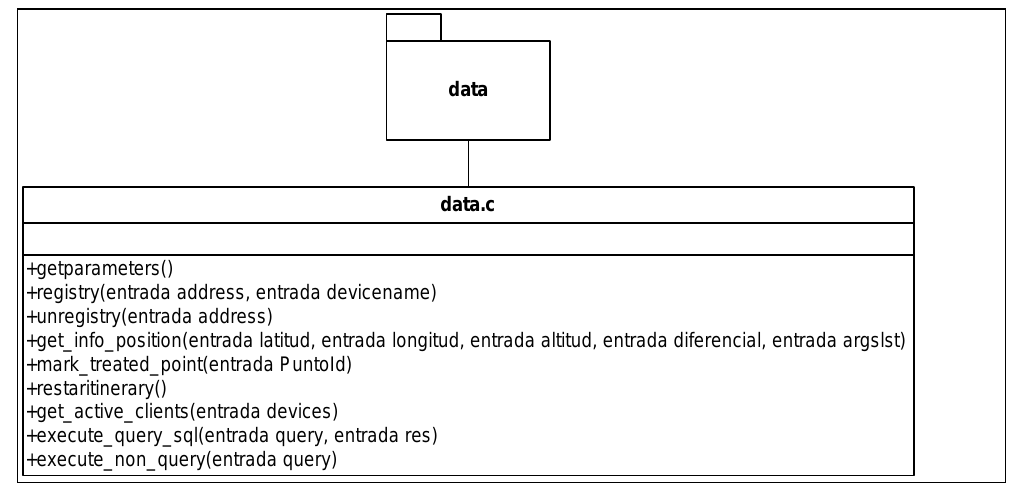
Figure 13. Class Diagram of the data access